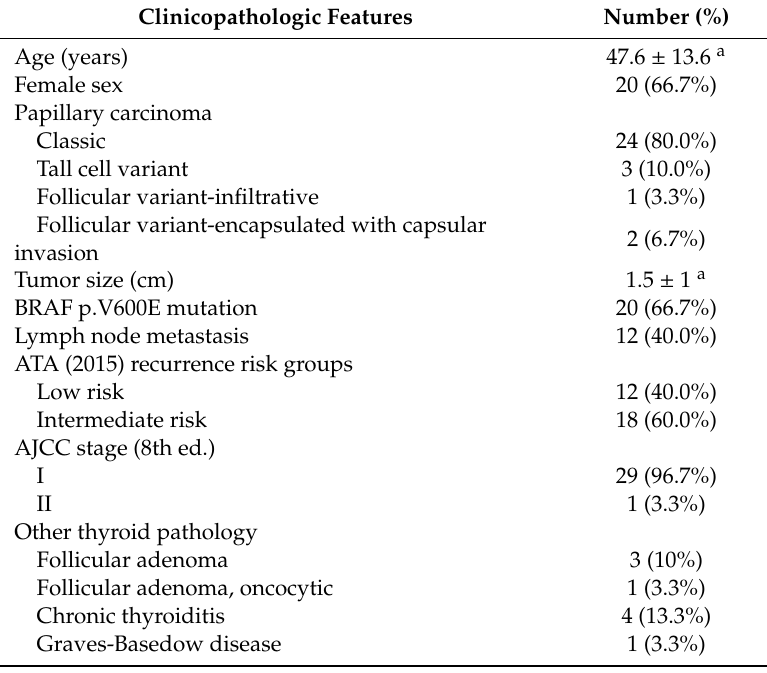
Table 1. Clinicopathologic characteristics of papillary thyroid carcinomas ( n =